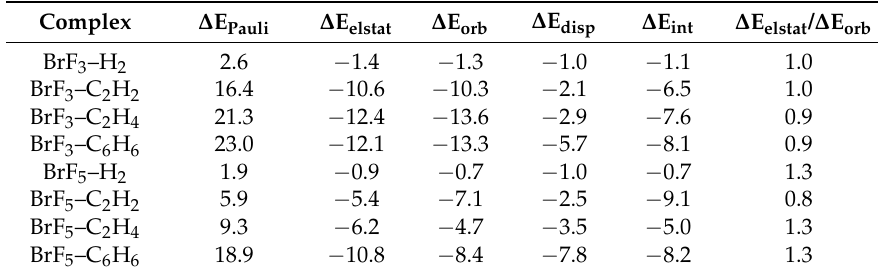
Table 2. The interaction energy decomposition terms (in kcal/mol); Pauli repulsion, Δ E Pauli , electrostatic, Δ E elstat , orbital, Δ E orb , dispersion, Δ E disp , the total interaction energy, Δ E int (in kcal/mol) and the ratio between electrostatic and orbital terms.